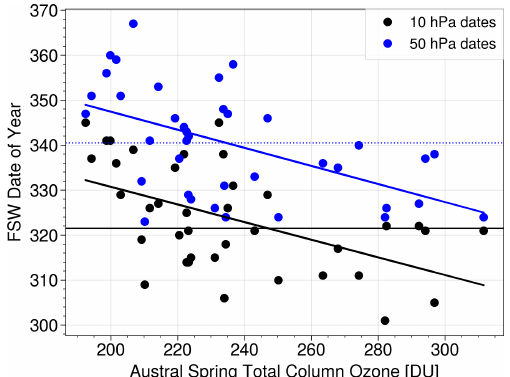
Figure 2. Polar cap total column ozone (TCO) (Dobson units) av- eraged from 7 September–13 October for each year vs. the FSW date in the SH (1979–2019) using zonal-mean zonal winds be- low 0ms − 1 at 10hPa (black) or below 10ms − 1 at 50hPa (blue). The solid (dashed) horizontal line indicates the median date for FSW dates defined at 10 (50) hPa. TCO data are from the Bodeker Scientific filled total column ozone (TCO) database (Version 3.4) (Bodeker et al., 2020); see Sect.